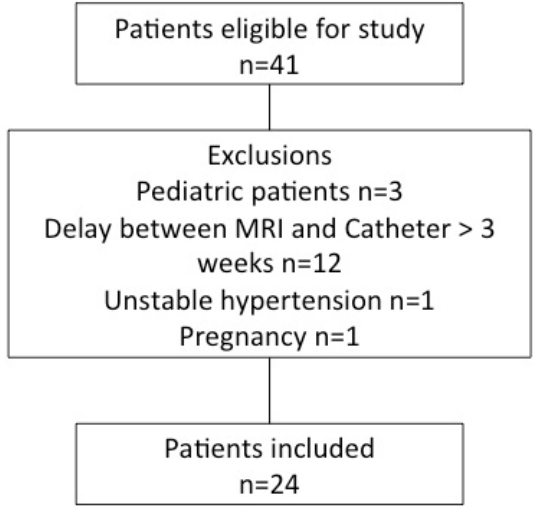
Figure 1. Flow Figure 1. Flow chart.